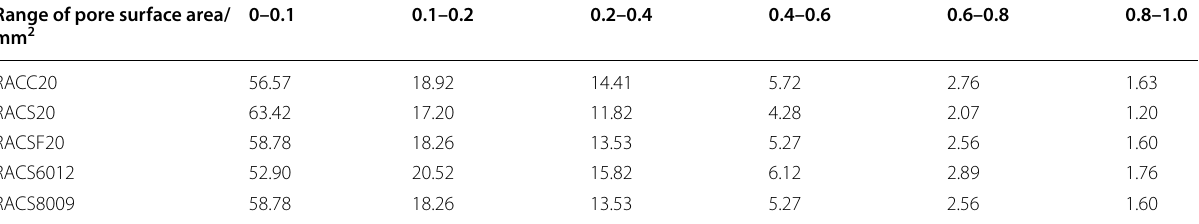
Table 5 Percentage value of pore surface area in different ranges (%) Range of pore surface area/ mm 2